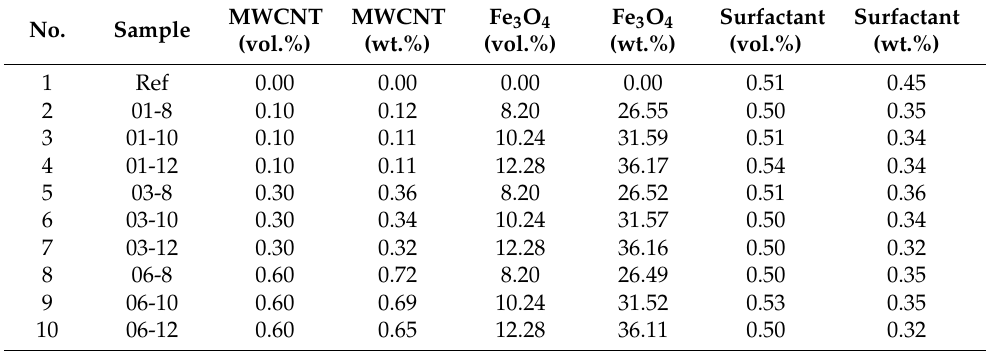
Table 1. Filler and surfactant